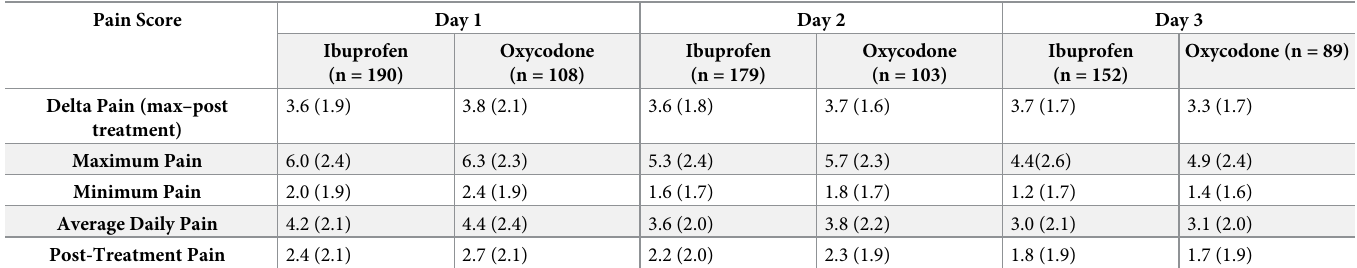
Table 3. Mean pain scores, Days 1–3.